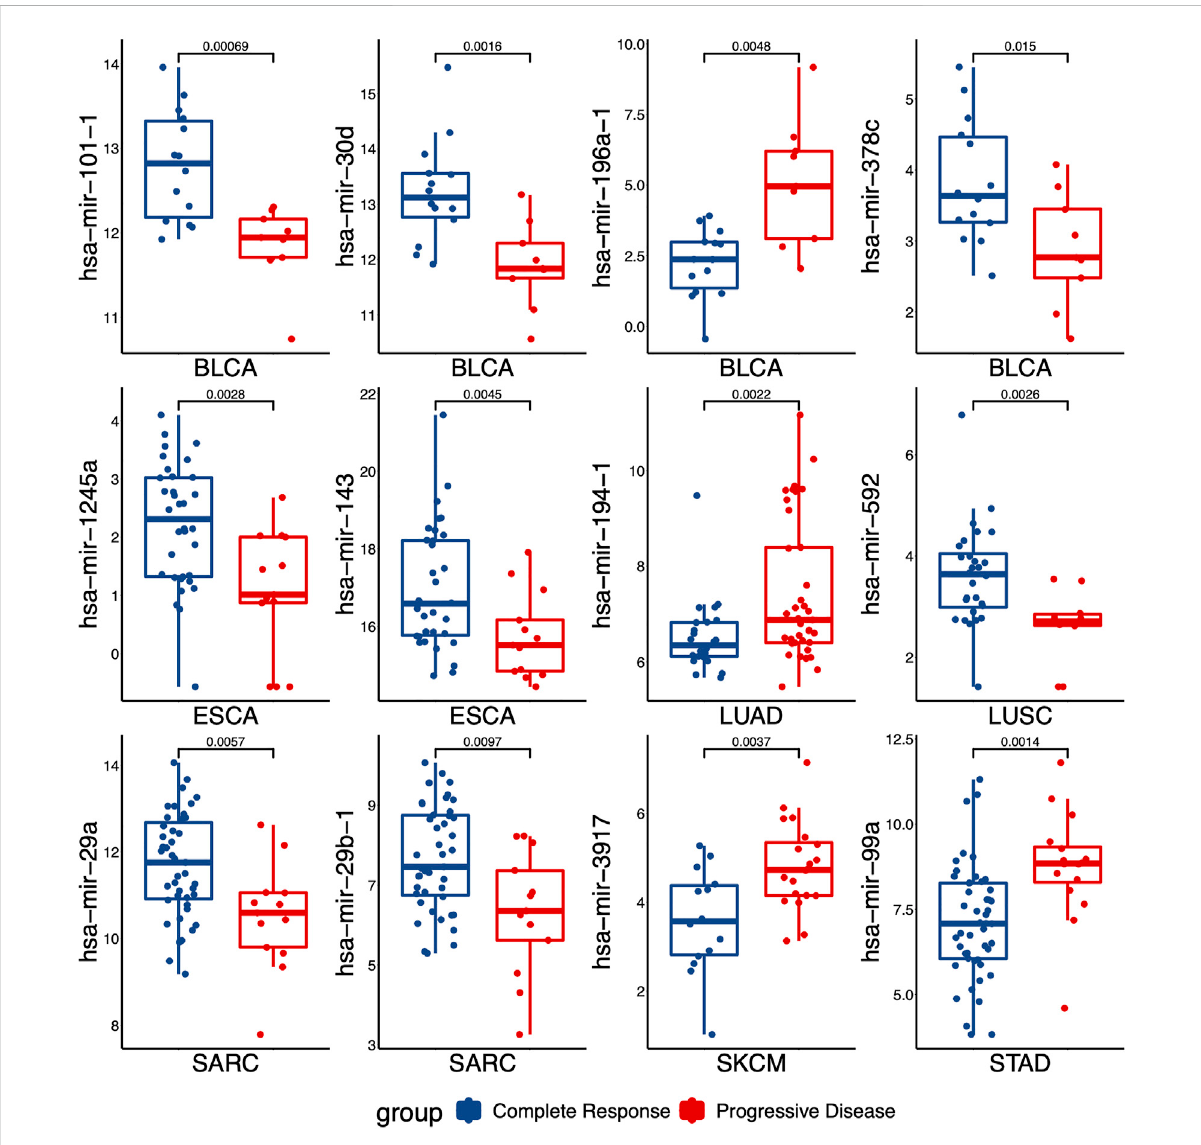
FIGURE 2 The levels of miRNAs expression that were differentially expressed between the responding (complete response) versus non-responding (progressive disease) tumors. p values were calculated by